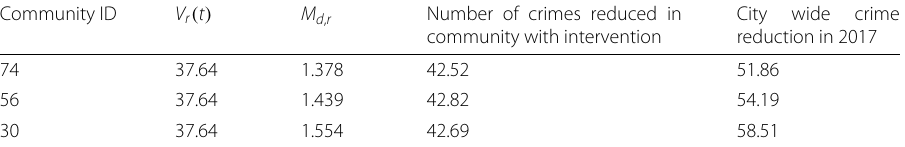
Table 4 The three least influential communities (in the increasing order of their branching rate of crime reduction) for the year 2016 are 74, 56, and 30. We look at how deploying interventions to different communities impacts the 2017 reduction in the number of crimes in the entire city Community ID V r ( t ) M d , r Number of crimes reduced in City wide crime community with intervention reduction in